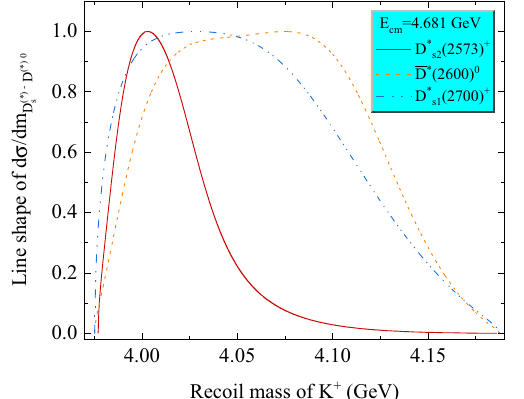
Fig. 1 Line shapes of recoil mass spectra of K + for e + e − → ( 2573 ) + D ∗− D ∗ s s 2